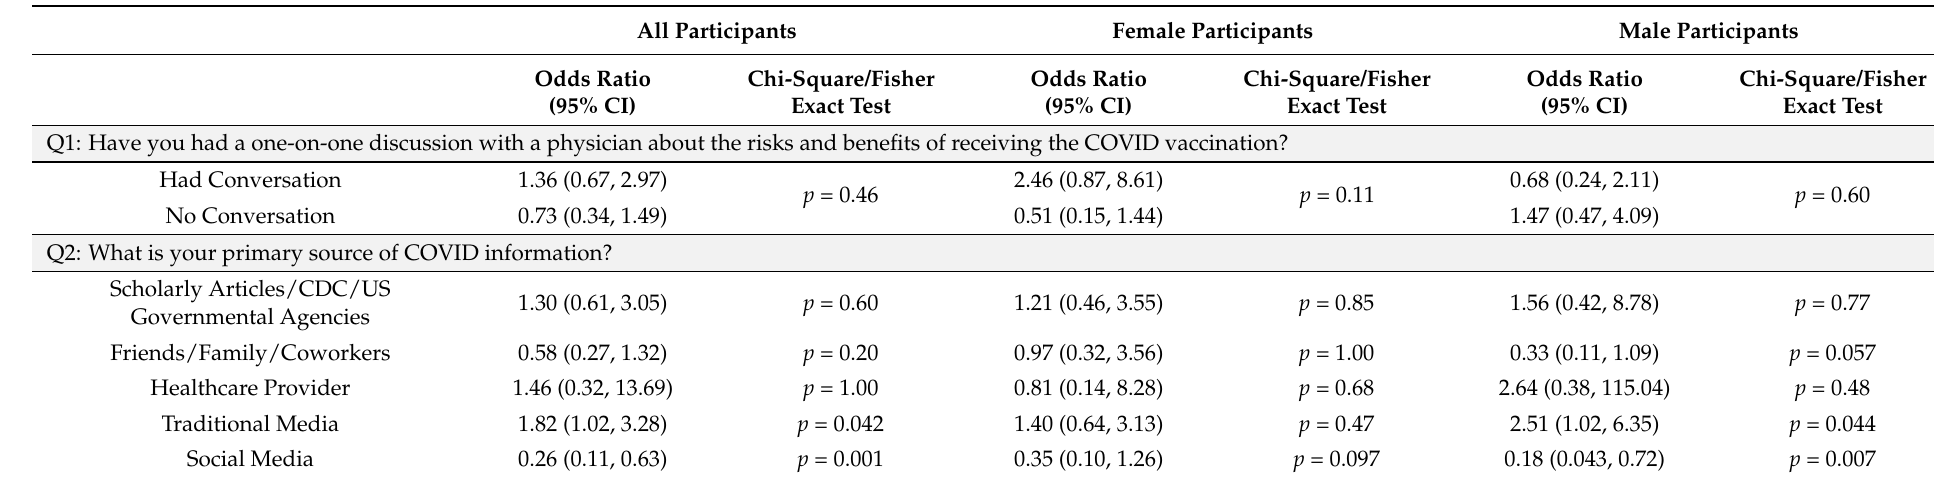
Table 2. Survey question responses amongst the neurological patient cohort and stratified by sex: crude odds